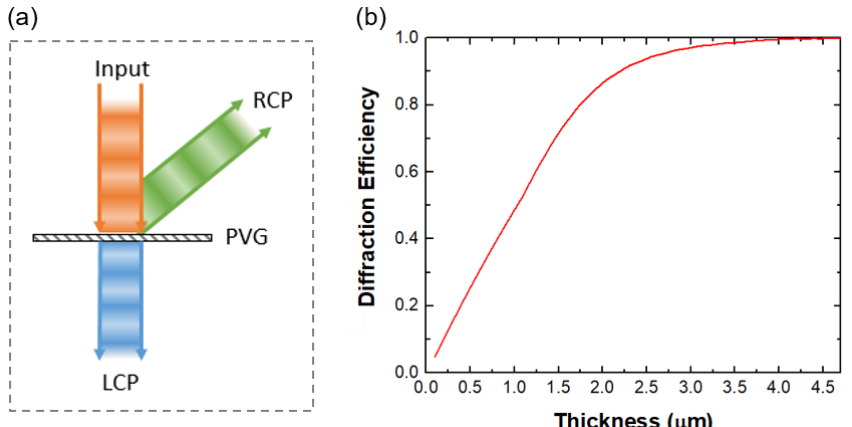
Figure 2. ( a ) Schematic of the beam diffracted by a PVG. ( b ) Simulated diffraction efficiency as a function of film thickness. The diffraction efficiency is defined as the ratio of first-order diffracted light to incident light at a specific diffraction angle and center wavelength. The horizontal period is 440 nm, vertical period is 205 nm, Δ n = 0.15, the diffraction angle is 50°, and the central wavelength is 532 nm. The efficiency is higher than 95% when the thickness exceeds 3 µm.